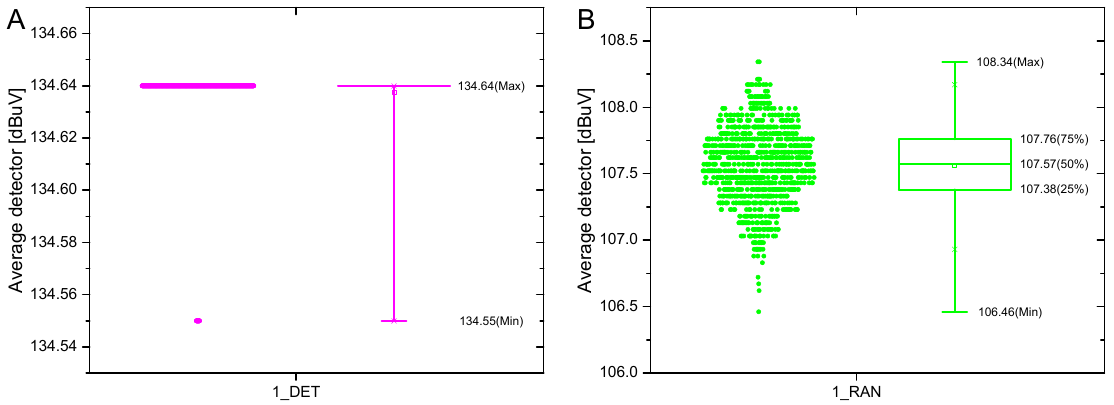
Figure 7. Box-and-whisker plots of 1000 average detector 1 s measurements for one DC/DC